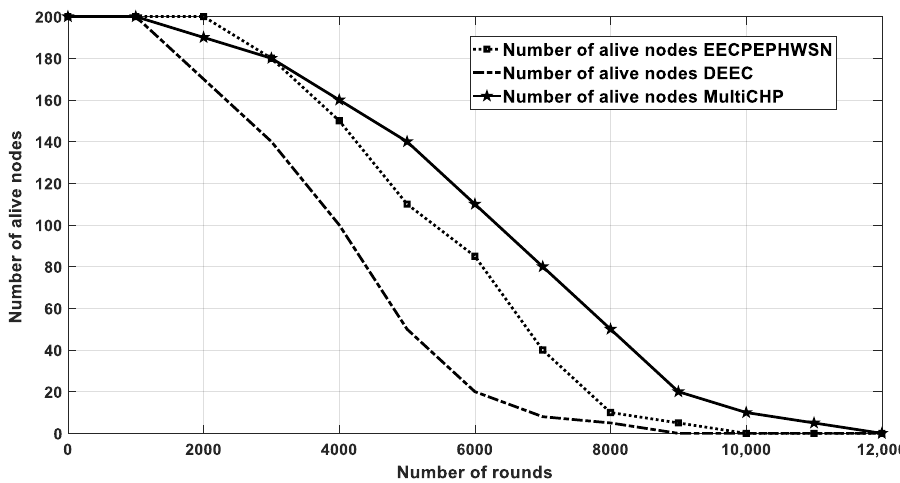
Figure 21. The number of alive nodes after each iteration. The network lifetime is calculated when all nodes in the network consume their energy.